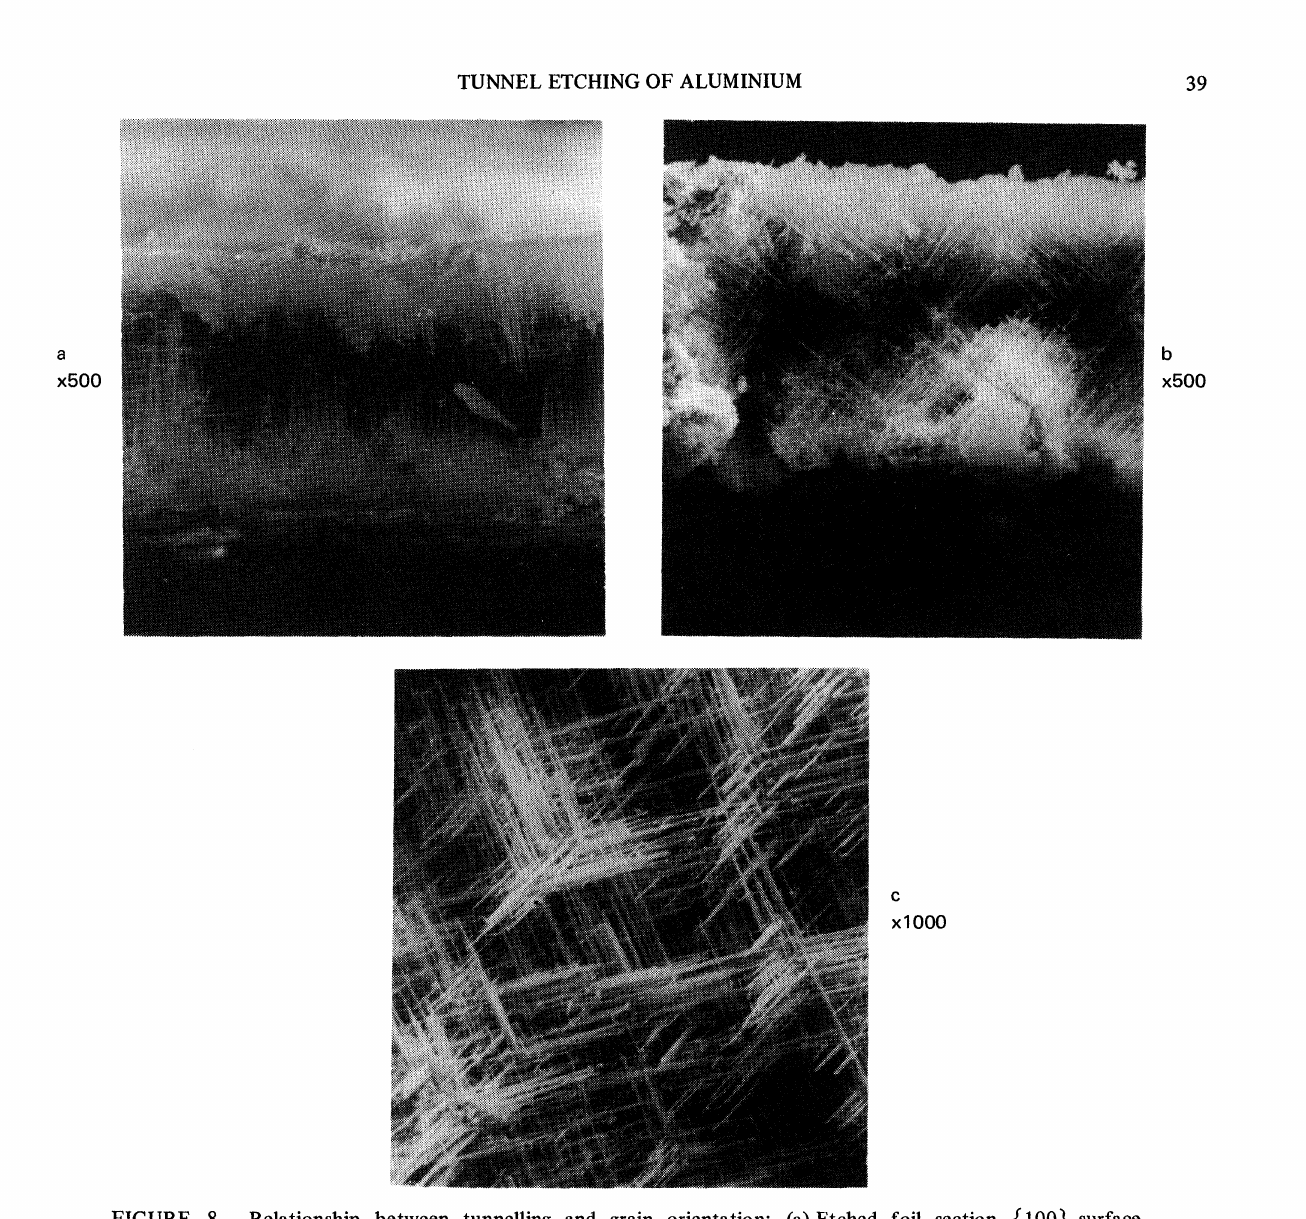
Relationship between tunnelling and grain orientation: (a)Etched foil section, { 100} surface orientation; (b) Etched foil section { 110 } surface orientation; (c) Single crystal { 111} surface